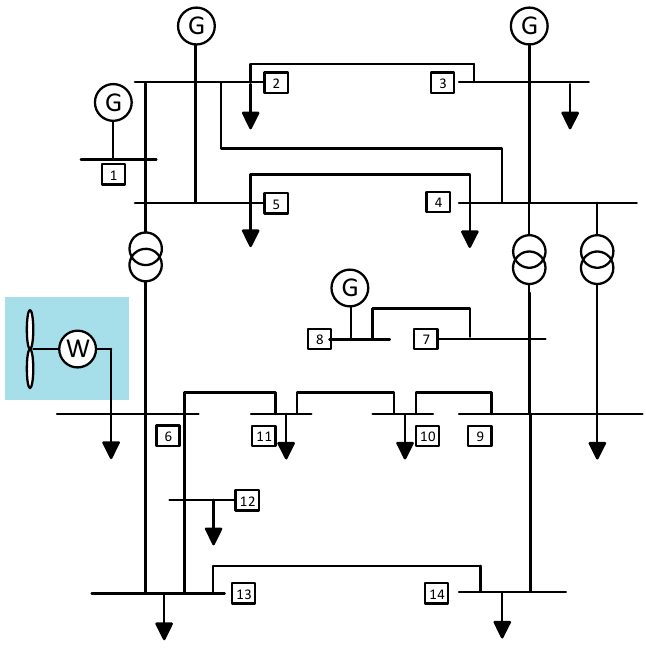
Figure 7. Five machine fourteen bus test system.